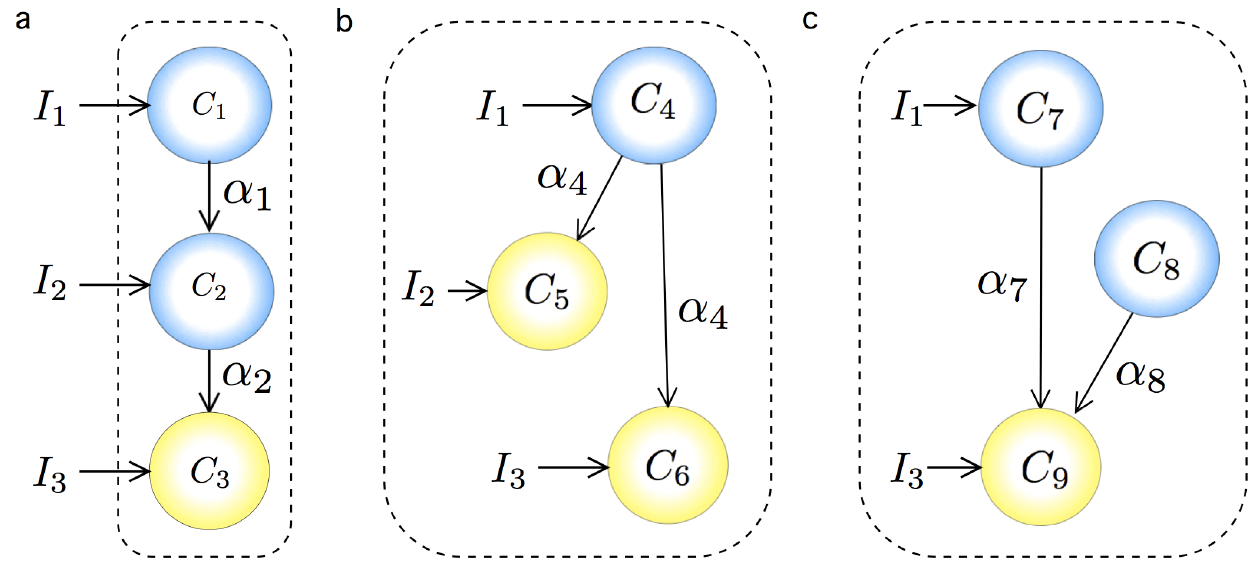
Figure 3. A general circuit design can be obtained by starting from a multicellular system where each virtual cell is a given logic gate. Here each engineered cell is indicated as C q and wires generated by C q are indicated as a q . Cell C q will produce an output according with the . Here g k represents the k -th logic gate responding to two inputs, the external one I i and the internal wire a j secreted by cell C j . logic defined by g k ij ij (thus only the identity or NOT are possible). Different motifs of connections can emerge according The upper layer involves single-input gates, i.e. g k i 0 with the criteria introduced, such as independent strings of connected cells, where each cell responds to different wire (a), the same wire can be sensed by more than one cell (b), or a given cell responds to wires produced in more than one cell (c). In this last case, due to cells only can sense two inputs (one external and one internal) all wires produced in different parts of the circuit but sensed by the same cell must be implemented using the same diffusible molecule, i.e. wire a 7 and a 8 are implemented by the same molecule, which can be produced in cells C 7 and C 8 independently. This situation corresponds to an implicit implementation in C 9 of the OR logic with respect to wires a 7 and a 8 . Yellow cells ( C 3 , C 5 , C 6 and C 9 ) can produce independently the final output signal e.g. a GFP.